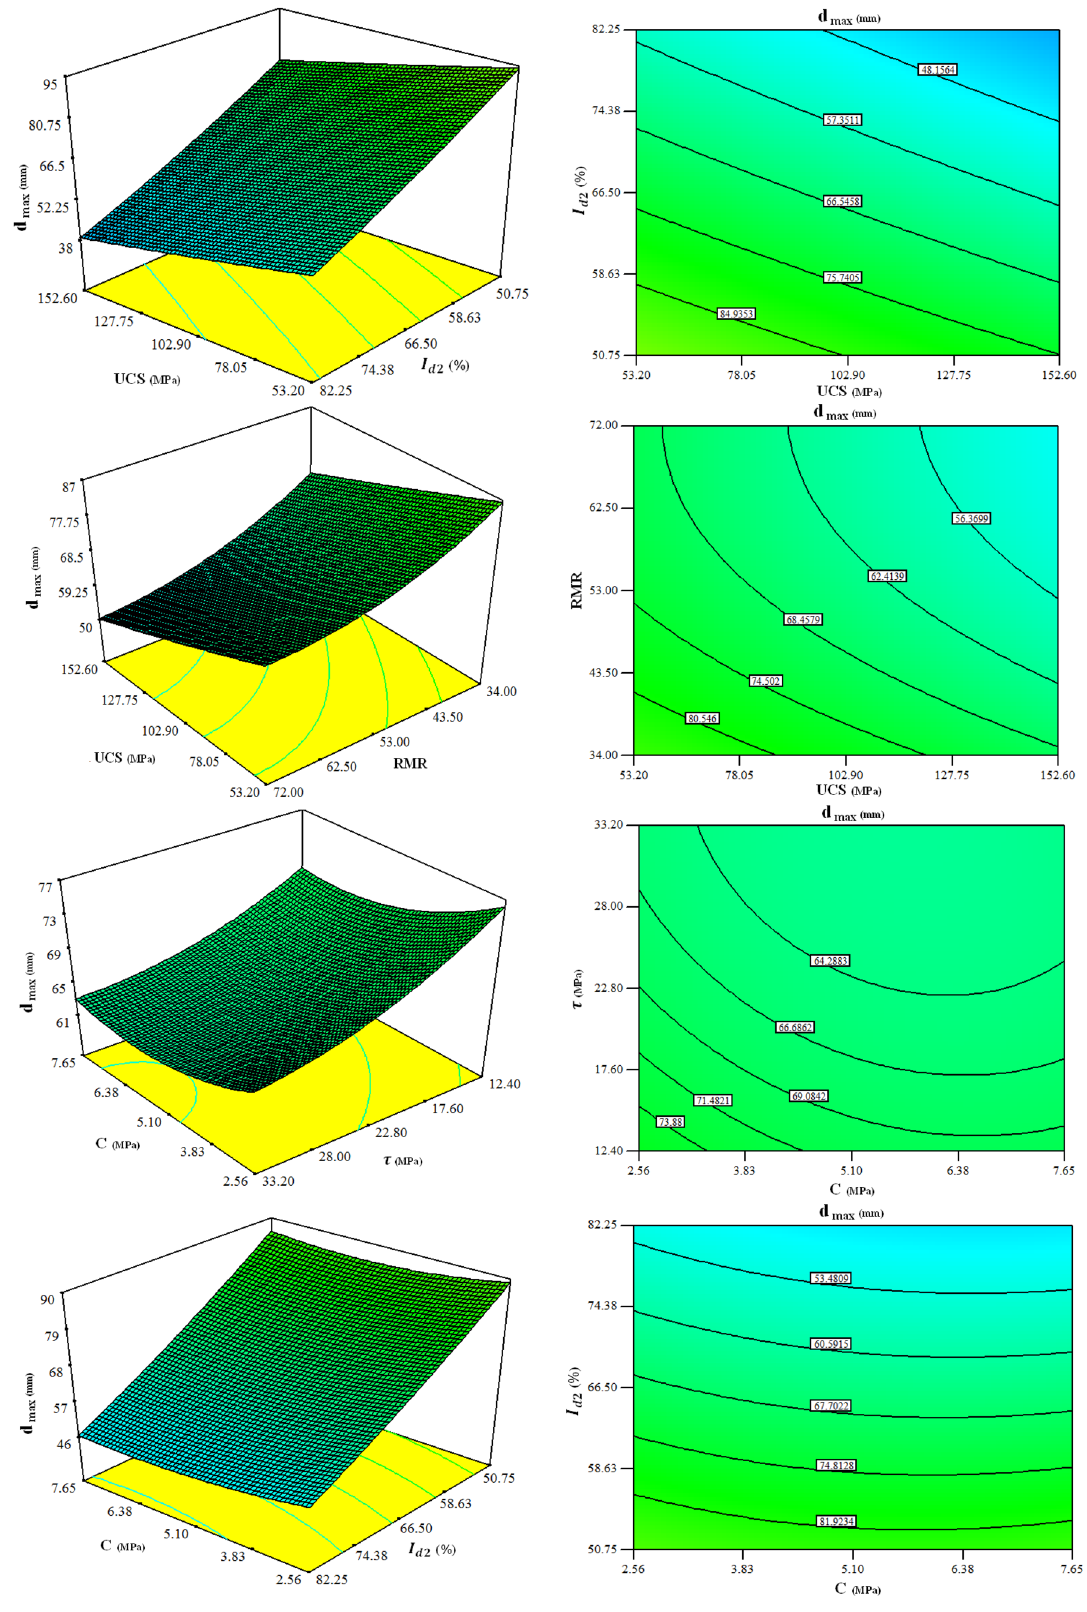
Figure 14. 3D response surface plots showing interaction effects of variables on the d max